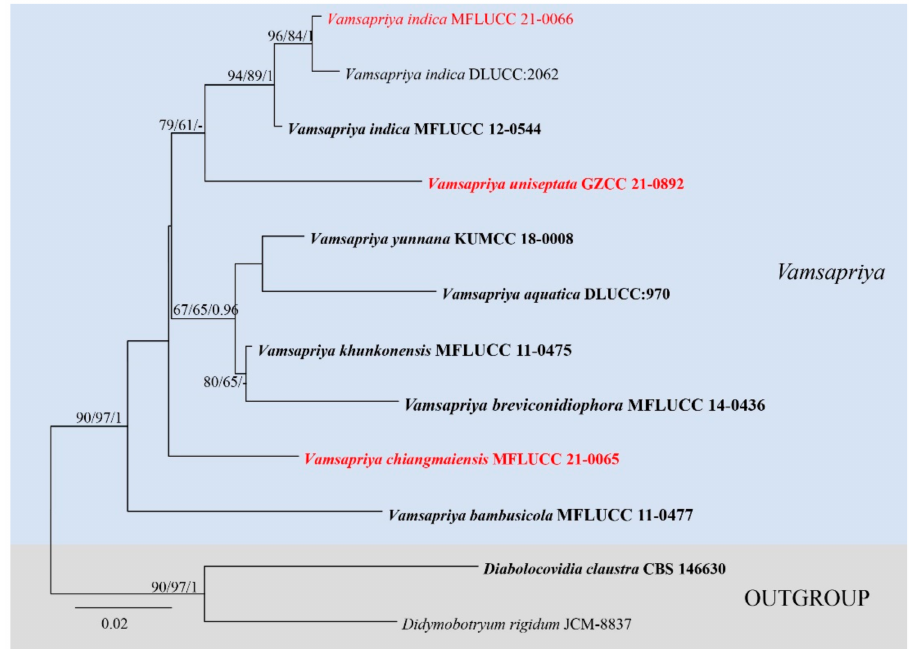
Figure 2. Maximum likelihood (RAxML) tree for Vamsapriya , based on ITS sequence data. The tree is rooted with Diabolocovidia claustra (CBS 146630) and Didymobotryum rigidum (JCM-8837). Ex-type strains are in bold, the new isolates are in